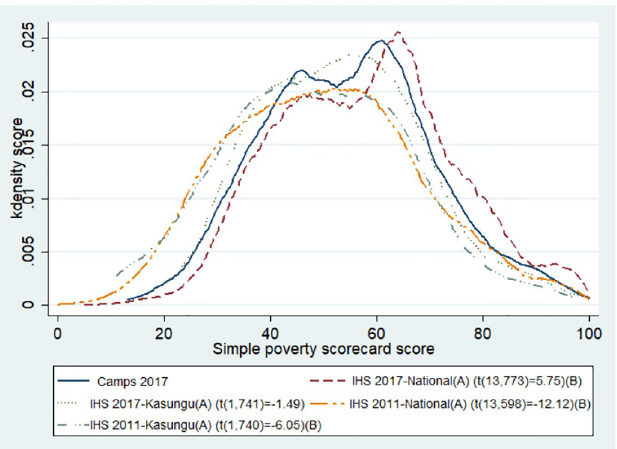
Fig 3. Simple poverty scorecard results, comparison by sample. (A) Weighted using IHS household sampling weights. (B) STATA survey design adjusted samples t-tests of independence with camp participants, significant at alpha = 0.001 (two tails).